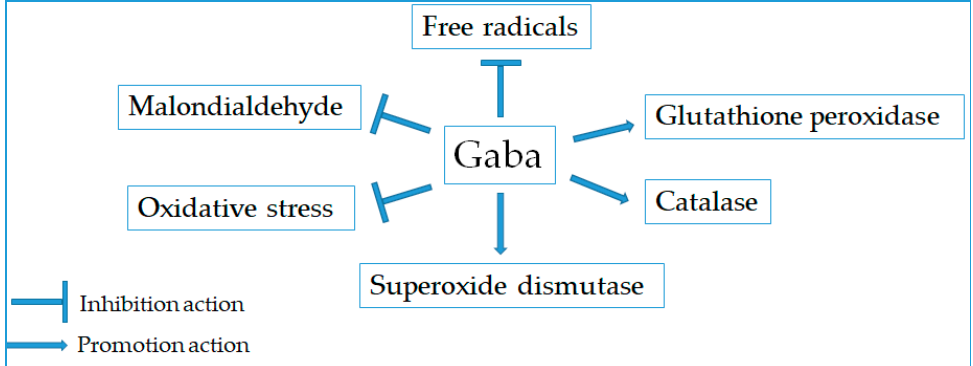
Figure 4. Modulatory activity of Gaba for antioxidant promotion.